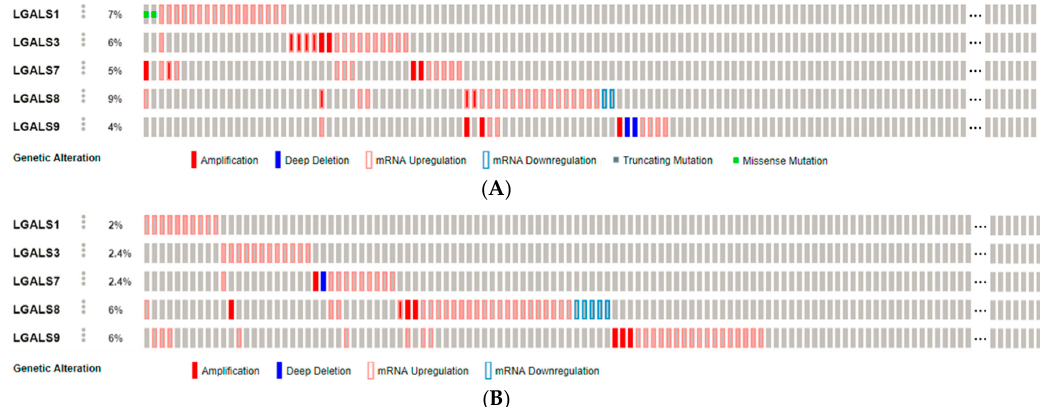
Figure 2. Alterations of galectin-1, -3, -7, -8, and -9 genes in head and neck squamous cell carcinoma ( A ) and thyroid cancer ( B ). Molecular alterations were investigated with the cBioPortal for Cancer Genomics [15], evaluating RNA expression, copy number variation, and mutation using The Cancer Genome Atlas (TCGA) datasets. Alteration events are displayed by samples (( A ), n = 279; ( B ), n = 507).